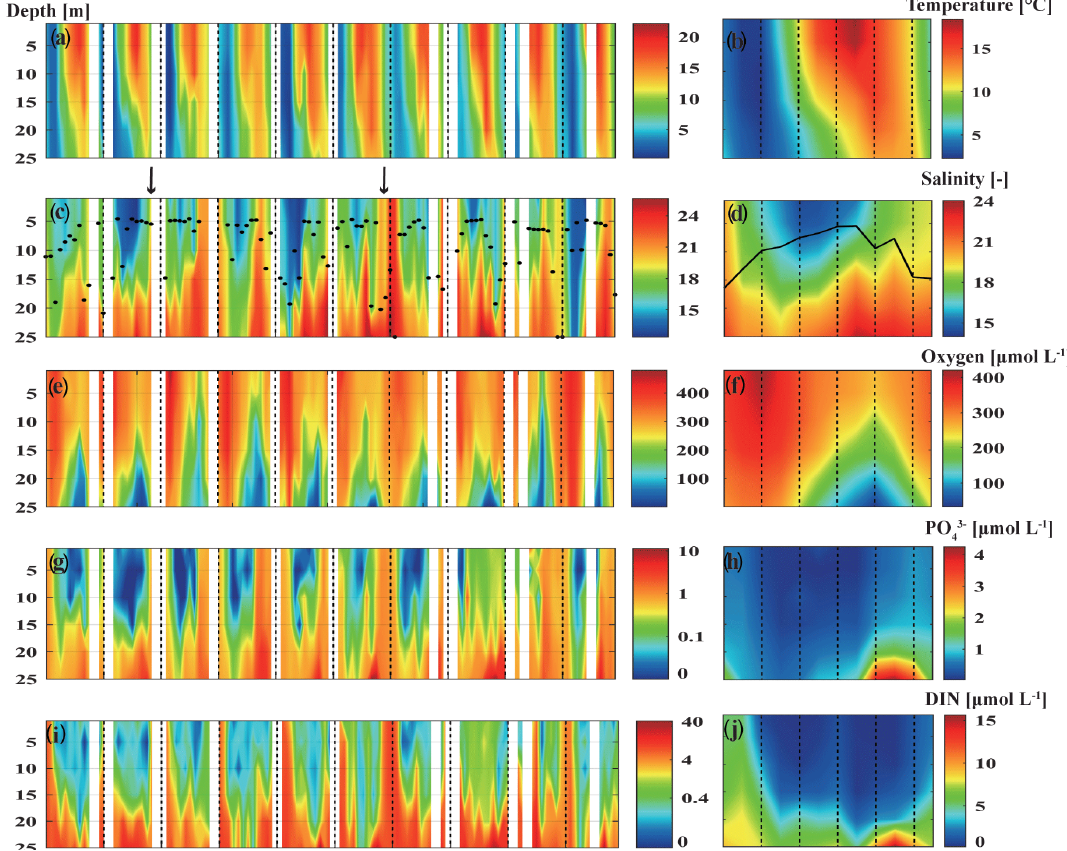
Figure 2. Monthly and mean seasonal distributions of temperature (a, b) , salinity (c, d) , dissolved O 2 (e, f) , phosphate (g, h) and dissolved inorganic nitrogen (i, j) at BE during 2009–2018. Please note that in the left panels the blank areas are due to data gaps caused by cancellations of the research cruises, and the dashed lines indicate January of each year. Black dots (c) and the black line (d) indicate monthly and mean seasonal distributions of the mixed-layer depth, respectively. The black arrows (c) indicate the major Baltic inflow (MBI) events in November 2010 and December 2014. Time–depth Hovmöller diagrams were generated with MATLAB; note that the colour coding in panels (g) and (i) is shown on a natural logarithmic